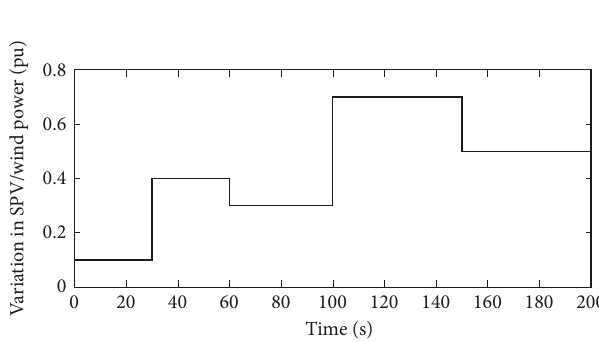
Figure 16: Pattern of solar/wind power